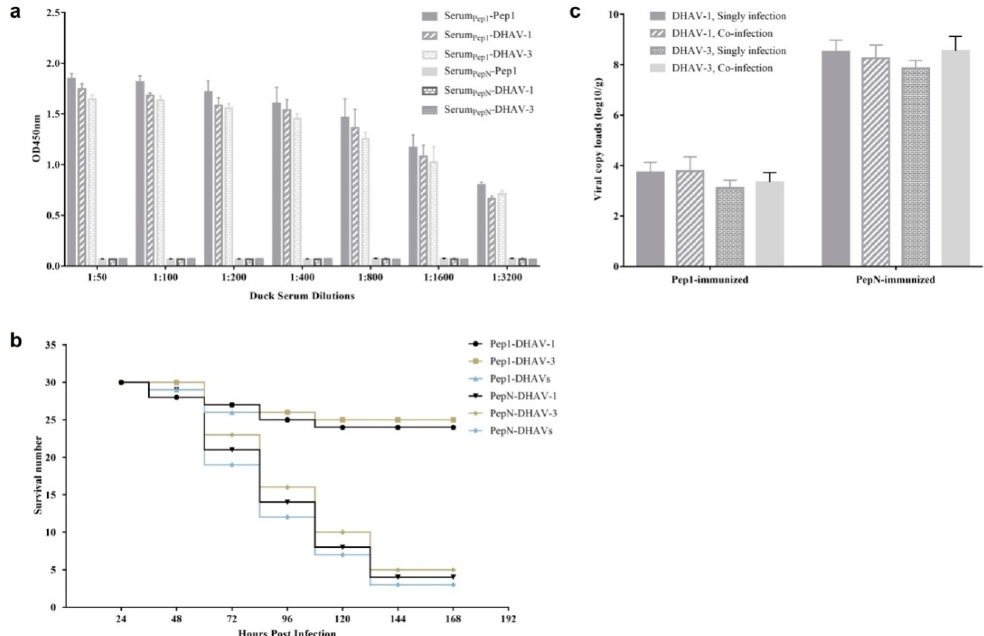
Figure 9. Immune effect analysis of ducklings immunized with synthetic Pep1-KLH: ( a )